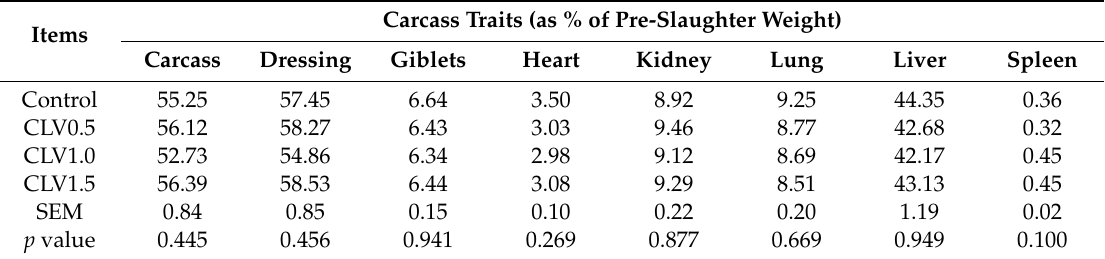
Table 4. Carcass traits of growing NZW rabbits as a ff ected by dietary treatments at 13 weeks of